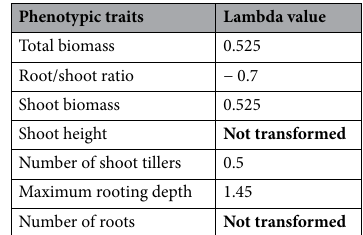
Table 1. Measured traits and lambda value used to transform the data. P < 0.05 is highlighted in